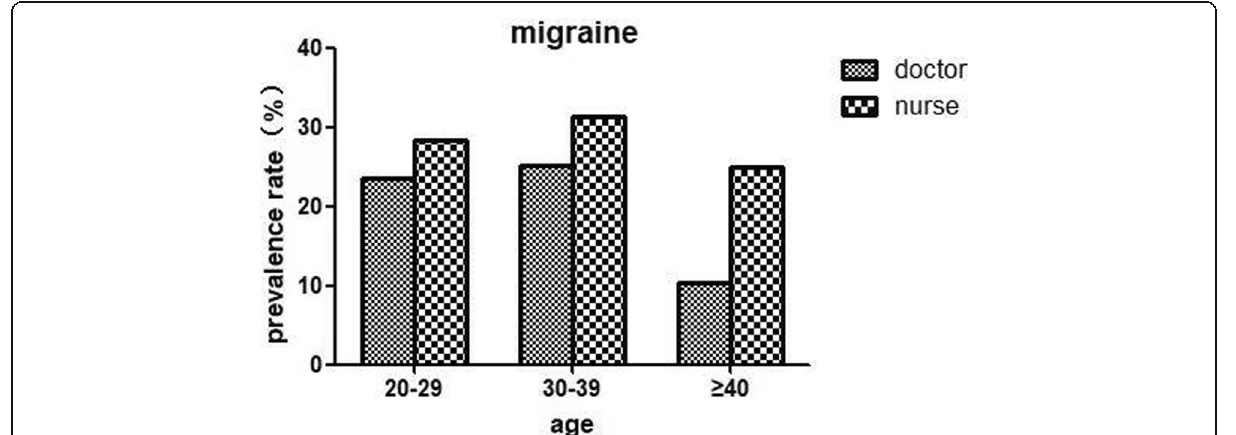
Fig. 3 Prevalence of migraine among doctors and nurses by age